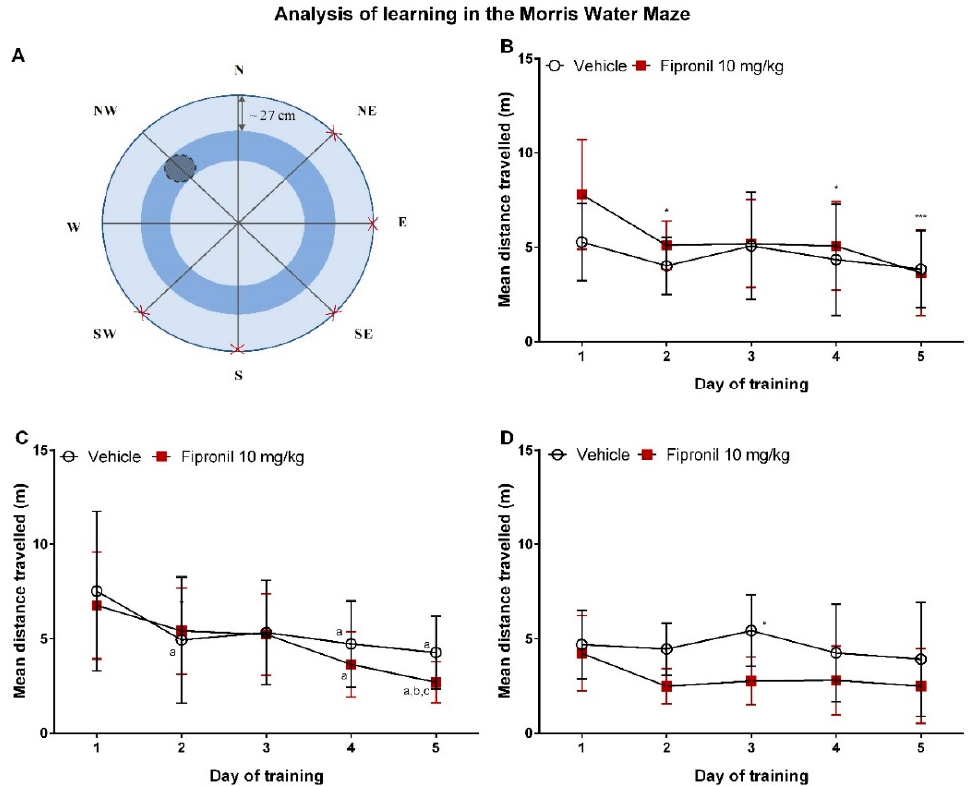
Figure 5. Analysis of learning in the Morris water maze. ( A ) Schematic representation of the Morris water maze tank with one possible platform position (grey circle surrounded by a dashed line) and the according possible starting positions indicated (red crosses). ( B ) Learning curve of animals during the training in the first session (performed after 20 treatments) of the Morris water maze task, as indicated by mean distance travelled in meters until island zone entry (Y axis) as a function of the day of the training (X axis). The day of training had a significant influence on the mean distance travelled ( p = 0.0016). ( C ) Learning curve of animals during the training in the second session (performed after 33 treatments) of the Morris water maze task, as indicated by mean distance travelled in meters until island entry (Y axis) as a function of the day of the training (X axis). The day of training had a significant influence on the mean distance travelled ( p < 0.0001; a: significantly different from day 1, b: significantly different from day 2, c: significantly different from day 3, intragroup analysis, Tukey’s multiple comparisons test) ( D ) Learning curve of animals during the training in the third session (performed after 45 treatments) of the Morris water maze task, as indicated by mean distance travelled in meters until island zone entry (Y axis) as a function of the day of the training (X-Axis). The day of